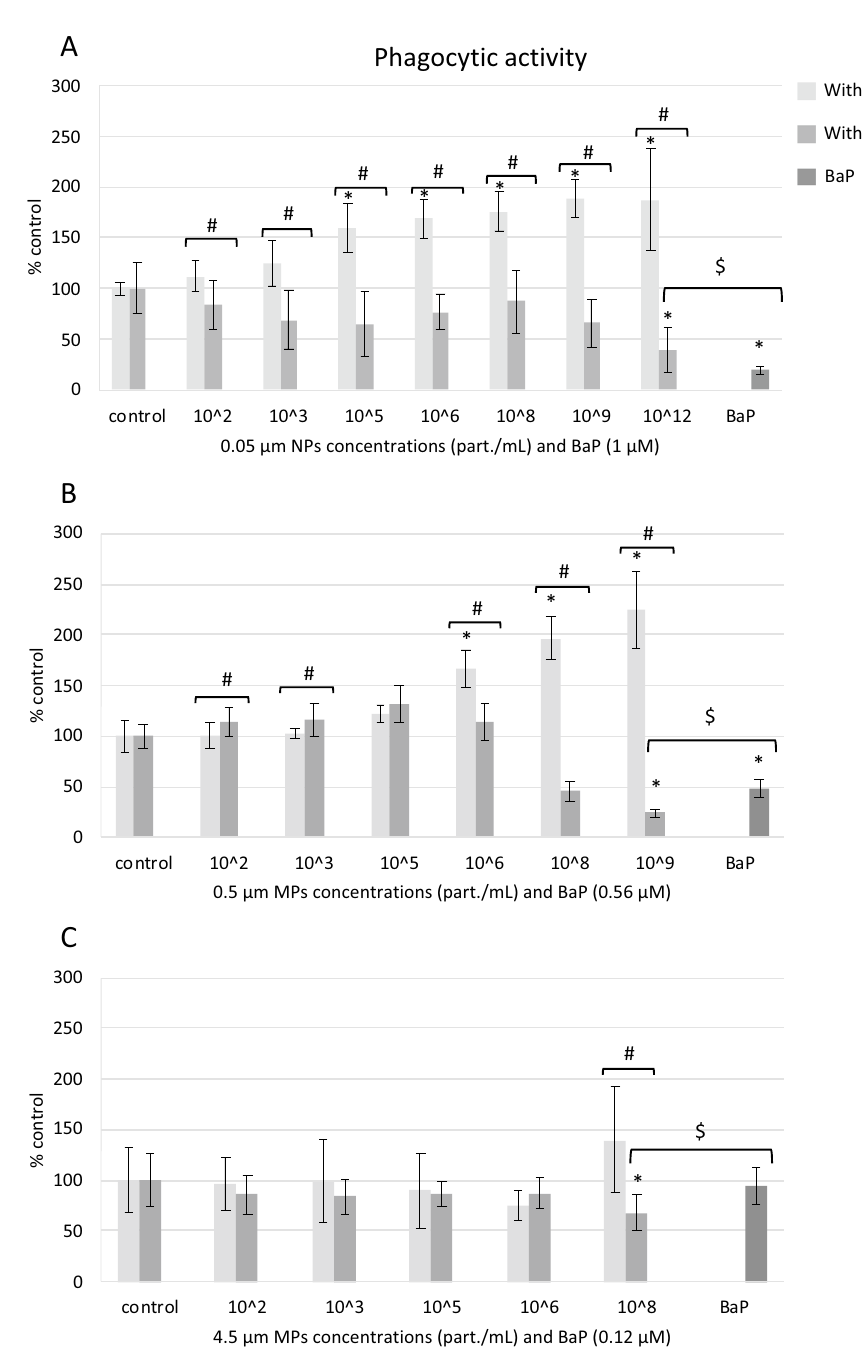
Figure 5. Phagocytic activity in mussel hemocytes exposed for 24 h to ( A ) 0.05 µm NPs, ( B ) 0.5 µm MPs and ( C ) 4.5 µm MPs alone or in combination with BaP and to BaP alone. Data are given as percentages with respect to control ± SD (n = 18). * indicates significant differences with respect to controls, # indicates significant differences between NPs/MPs with or without BaP and $ indicates significant differences between NPs/MPs with BaP and BaP